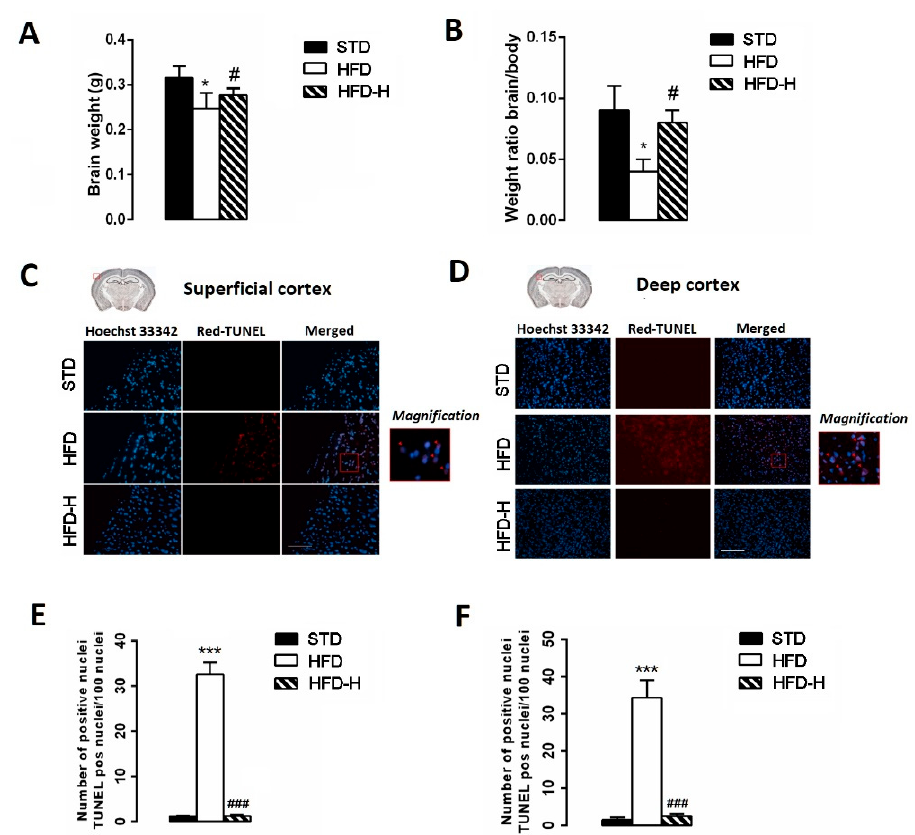
Figure 3. Impact of long-term honey ingestion on neuronal damage caused by HFD. Honey prevented neurodegeneration in HFD mice. ( A ) Brain weight; ( B ) Weight ratio brain/body; ( C ) TUNEL assay on superficial cerebral cortex sections; ( D ) TUNEL assay on deep cerebral cortex sections; ( E ) Number of apoptotic nuclei in superficial and deep ( F ) cerebral cortex in STD, HFD and HFD-H mice. Data are mean values ± S.E.M. ( n = 8/group). * p < 0.05, *** p < 0.001 vs. STD; # p < 0.05, ### p < 0.001